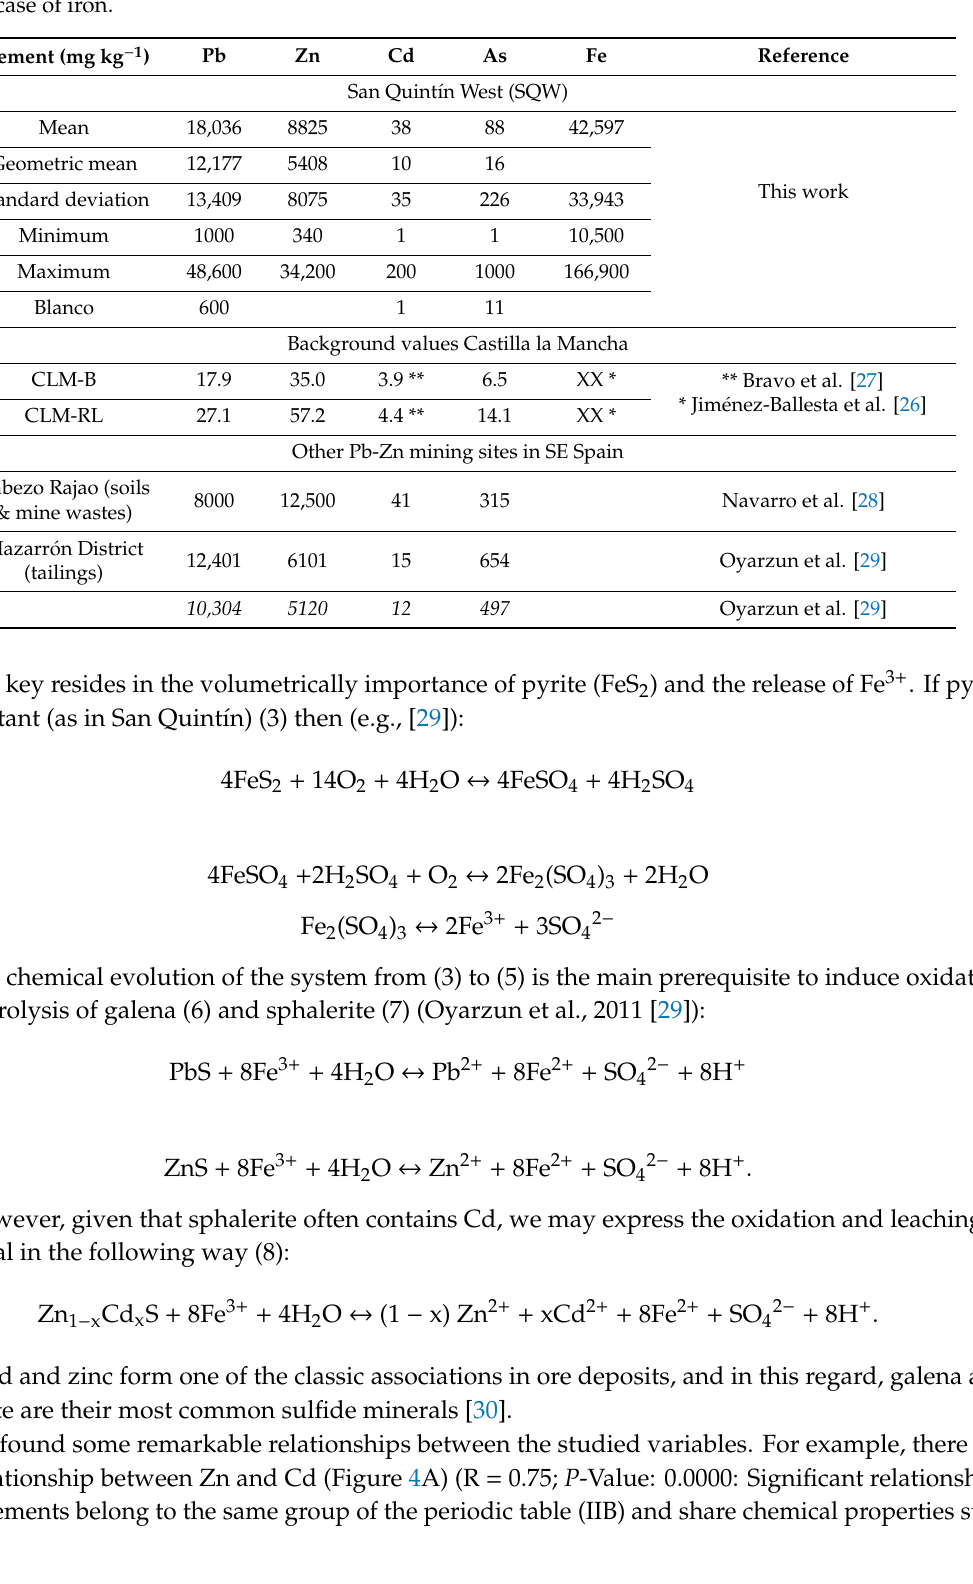
Table 2. Main statistics of geochemical values. CLM-B and CLM-RL: Background values for Castilla-La Mancha region, *: After Jim é nez-Ballesta et al. [26]; **: after Bravo et al. [27]. Means and geometric means ( italics ) for the San Quint í n West spolic technosols, and equivalent materials from abandoned Pb–Zn mining sites in SE Spain. We also calculated the geometric mean as di ff erent from the arithmetic mean as it dampens the statistical e ff ect of very high or low values; this procedure was not required in the case of